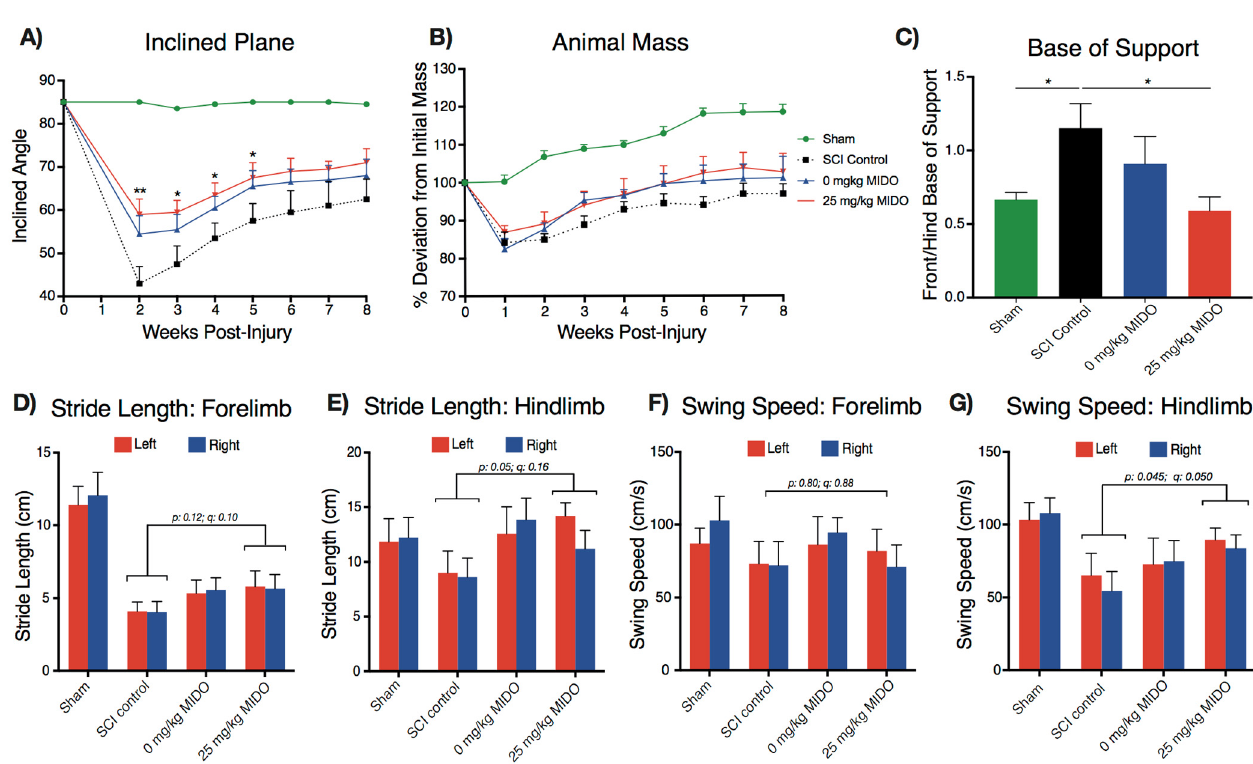
Figure 4. Acute administration of midostaurin improves functional recovery after cervical SCI ( n = 5 per cohort). ( A ) Inclined plane assessment; the 25 mg/kg midostaurin-treated group had significantly enhanced functional recovery compared to the SCI control. ( B ) Animal mass recorded weekly suggested an improved total body mass recovery in both the 0 mg/kg midostaurin and 25 mg/kg midostaurin cohorts compared to the SCI control. ( A , B ) Time-course data analyzed with two-way ANOVA using FDR according to the two-stage linear set-up procedure of Benjamini, Krieger, and Yekutieli to correct for multiple comparisons. Statistically significant changes are illustrated with an asterisk (*). ( C ) Improved hindlimb/forelimb base of support in the 25 mg/kg midostaurin group compared to the SCI control. The comparison was made by one-way ANOVA using Holm–Sidak for multiple comparisons (*: p < 0.05; **: p < 0.01). ( D – G ) CatWalk TM analysis demonstrated enhanced recovery in stride length and swing speed after DMSO and midostaurin administration (two-way ANOVA using FDR according to the two-stage linear set-up procedure of Benjamini, Krieger, and Yekutieli to correct for multiple comparisons). All data are presented as mean ±